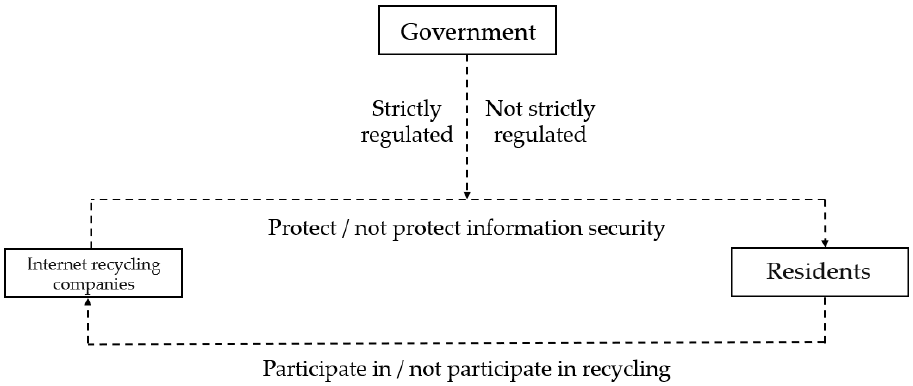
Figure 3. Relationships between stakeholders in the recycling of WEEE.